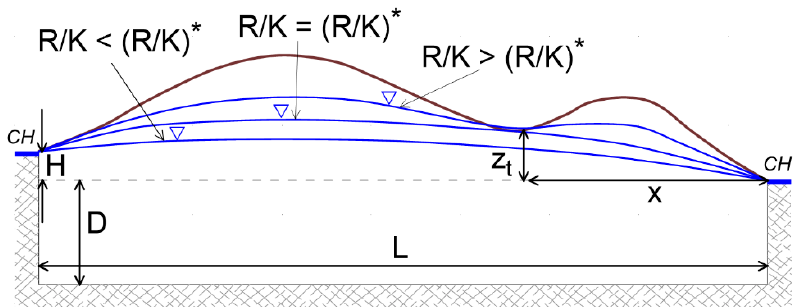
Figure A1. Conceptual schematic for the study of water-table exposures across the landscape. The water table is sketched for R/K smaller, equal, and larger than the threshold value (R/K) * for which the water table just crops out at x. (Adapted from Bresciani et al. [52]).